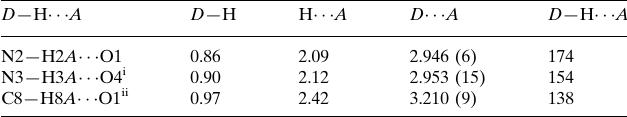
Hydrogen-bond geometry (A˚ , (cid:2)